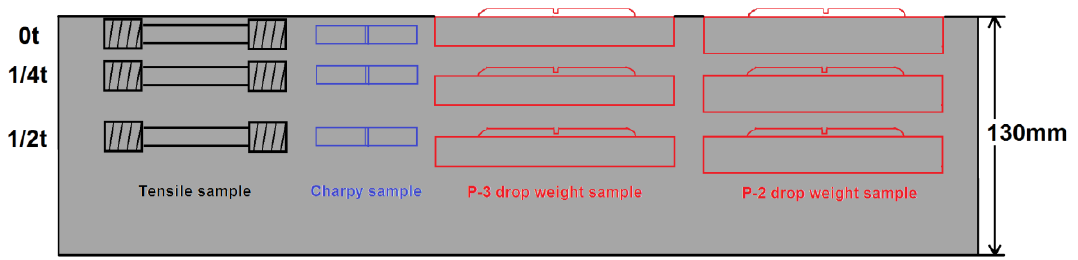
Figure 1. Schematic diagram of mechanical samples and the corresponding position in the plate section.